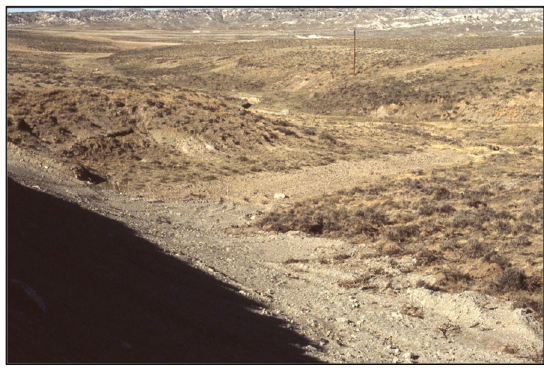
Fig. 3 Pre-disturbance native Shrubland community